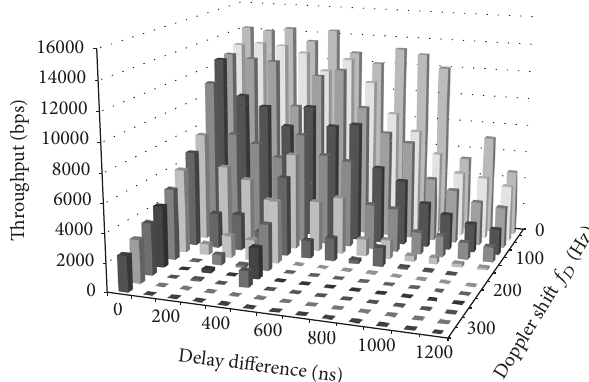
Figure 17: Results of WLAN throughput as a function of Doppler spread and delay